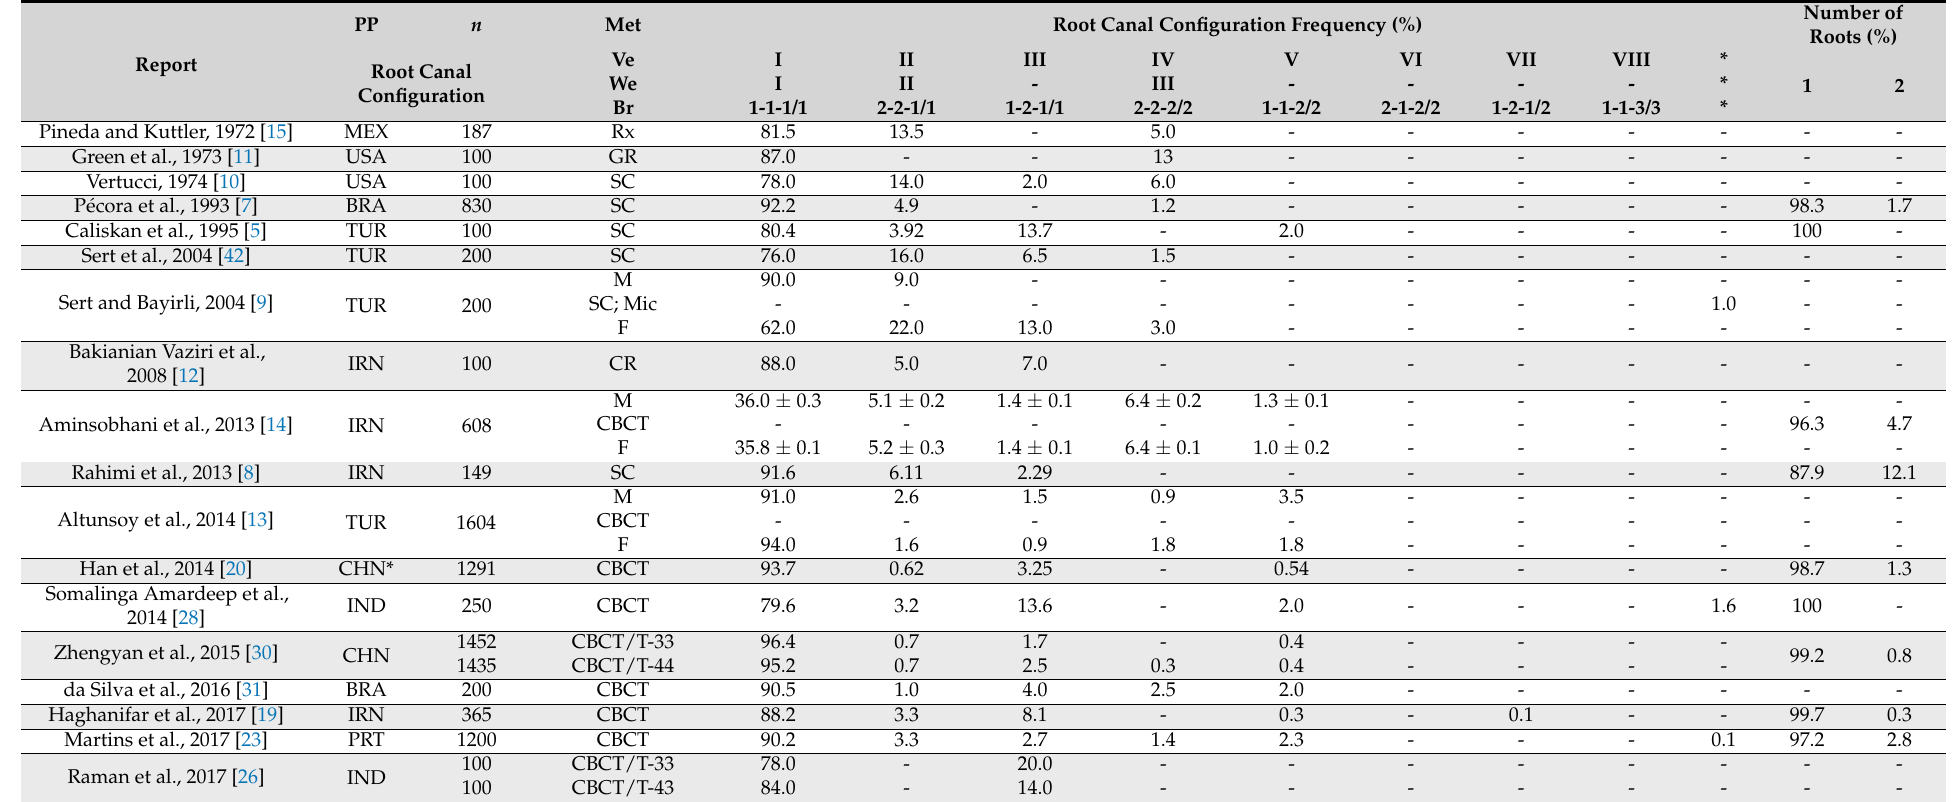
Table 1. Systematic literature review summary of different comparative and non-comparative morphologic investigations of the root canal configuration (RCC) of mandibular canines. The RCCs are depicted according to the classifications of Weine et al. (We) [2], Vertucci (Ve) [1] and Briseño-Marroqu í n et al. (Br) [3] (PP: Country three-digit code of population investigated; Met: Research methodology employed; -: no classification given/possible; *: other root canal configurations; CHN*: Chinese subpopulation; Cl: clearing method; Rx: radiographic